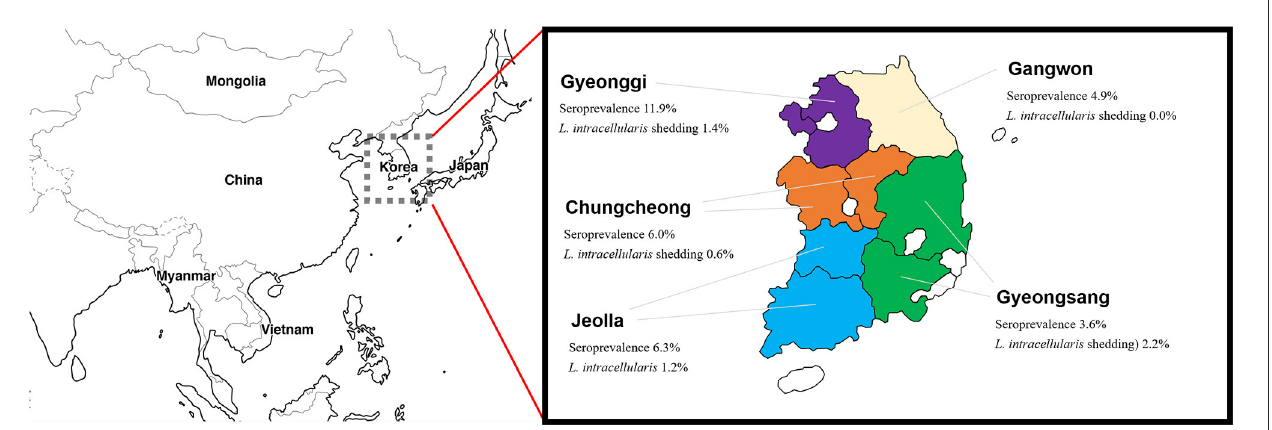
FIGURE1 Geographical location of the provinces of South Korea and prevalence of Lawsonia intracellularis in farmed rabbits.